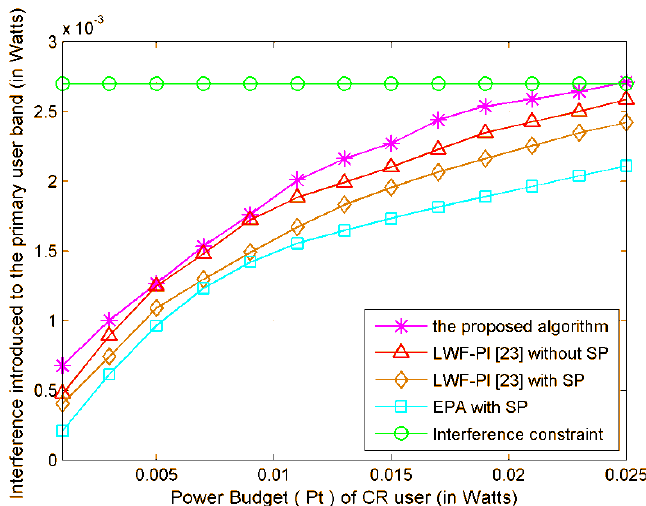
Figure 5. Power Budget versus interference introduced to PU